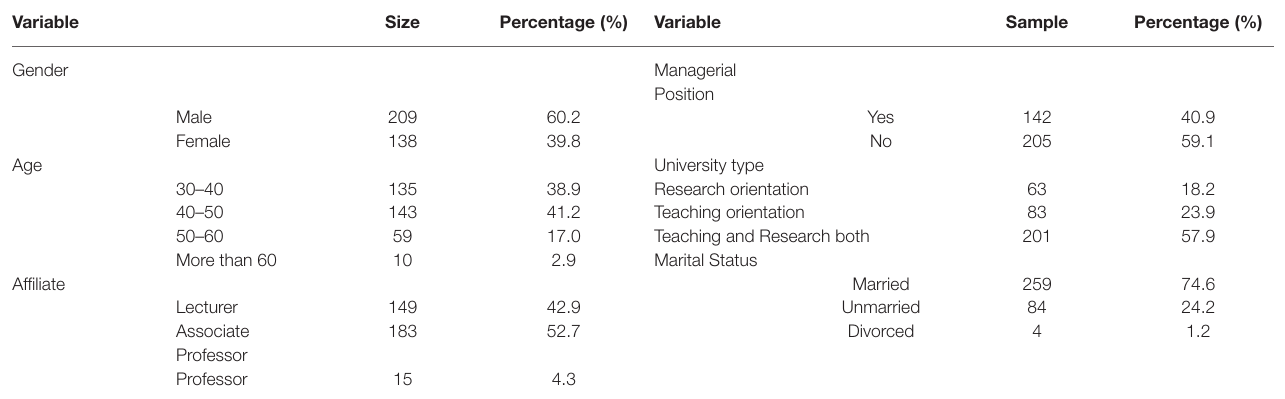
TABLE 1 | Demographic characteristics of research